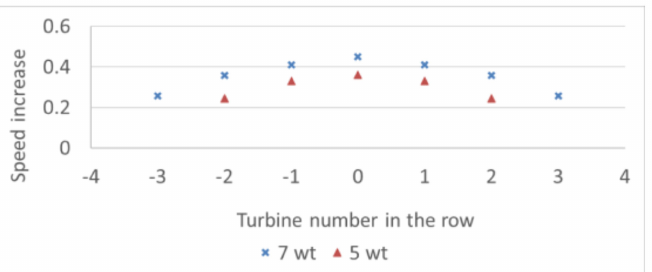
Figure 17. The effect of varying the number of turbines in a row. The percent of the speed increase in front of wind turbine rows compared to a row of one turbine.